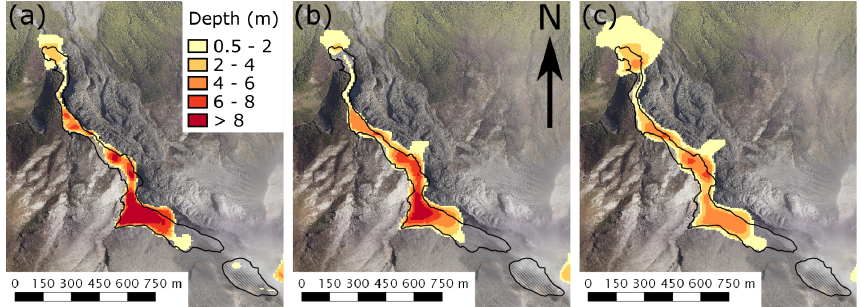
Figure 3. Simulated deposit depth for (a) Voellmy–Salm, (b) Pitman and Le (2005), and (c) Pudasaini (2012) models compared with the observed deposit and source outline (black). Aerial basemap sourced from LINZ Waikato Aerial Photos 2012–2013.